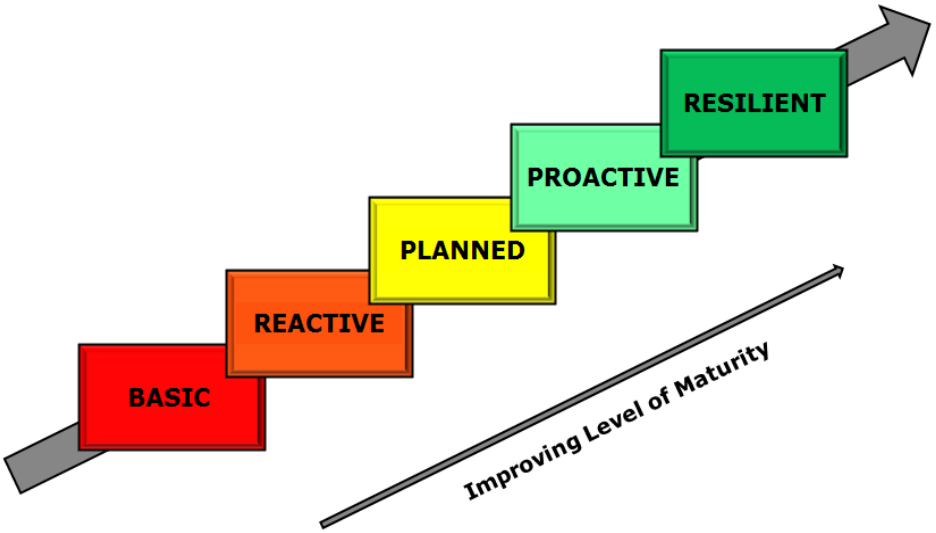
Figure 4 . UK Coal journey